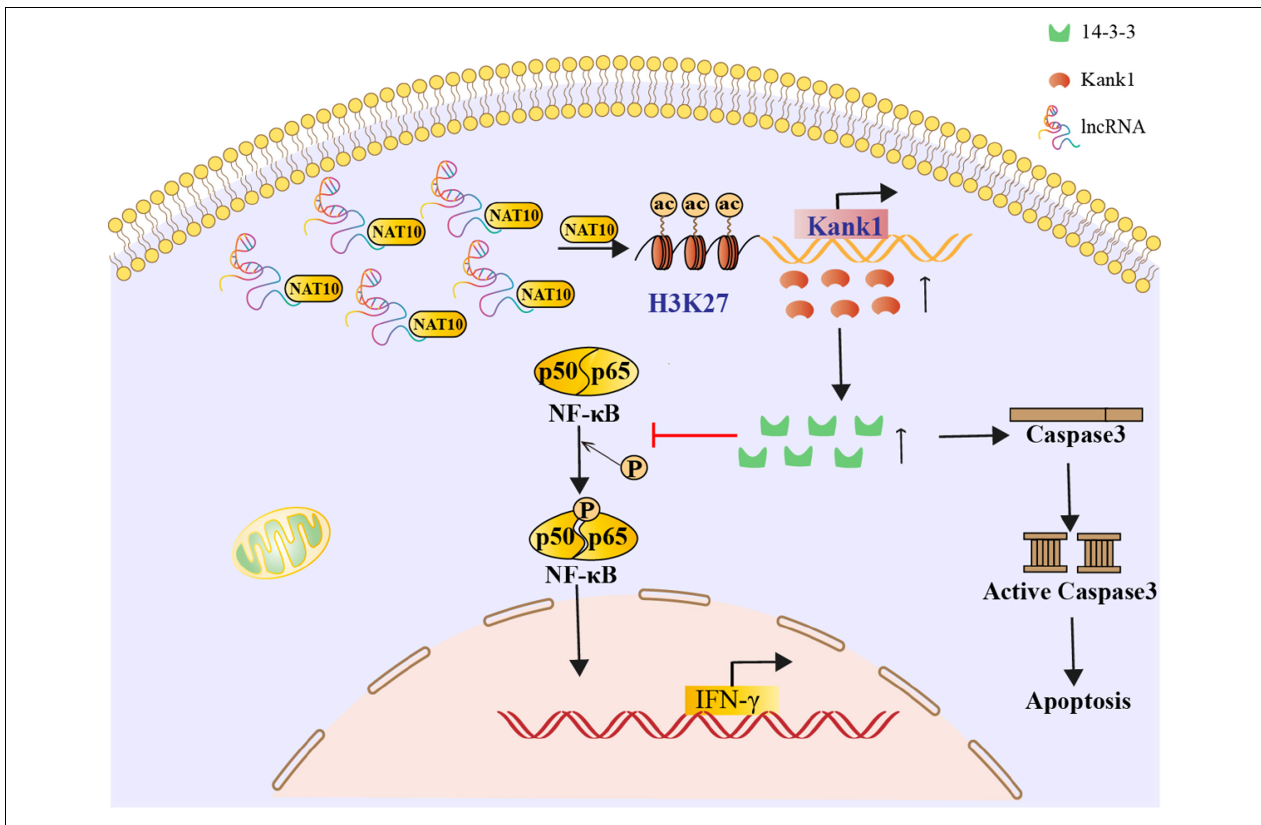
FIGURE 6 | A mechanistic diagram of T lymphocyte regulation by lncRNA-ENST00000421645 was